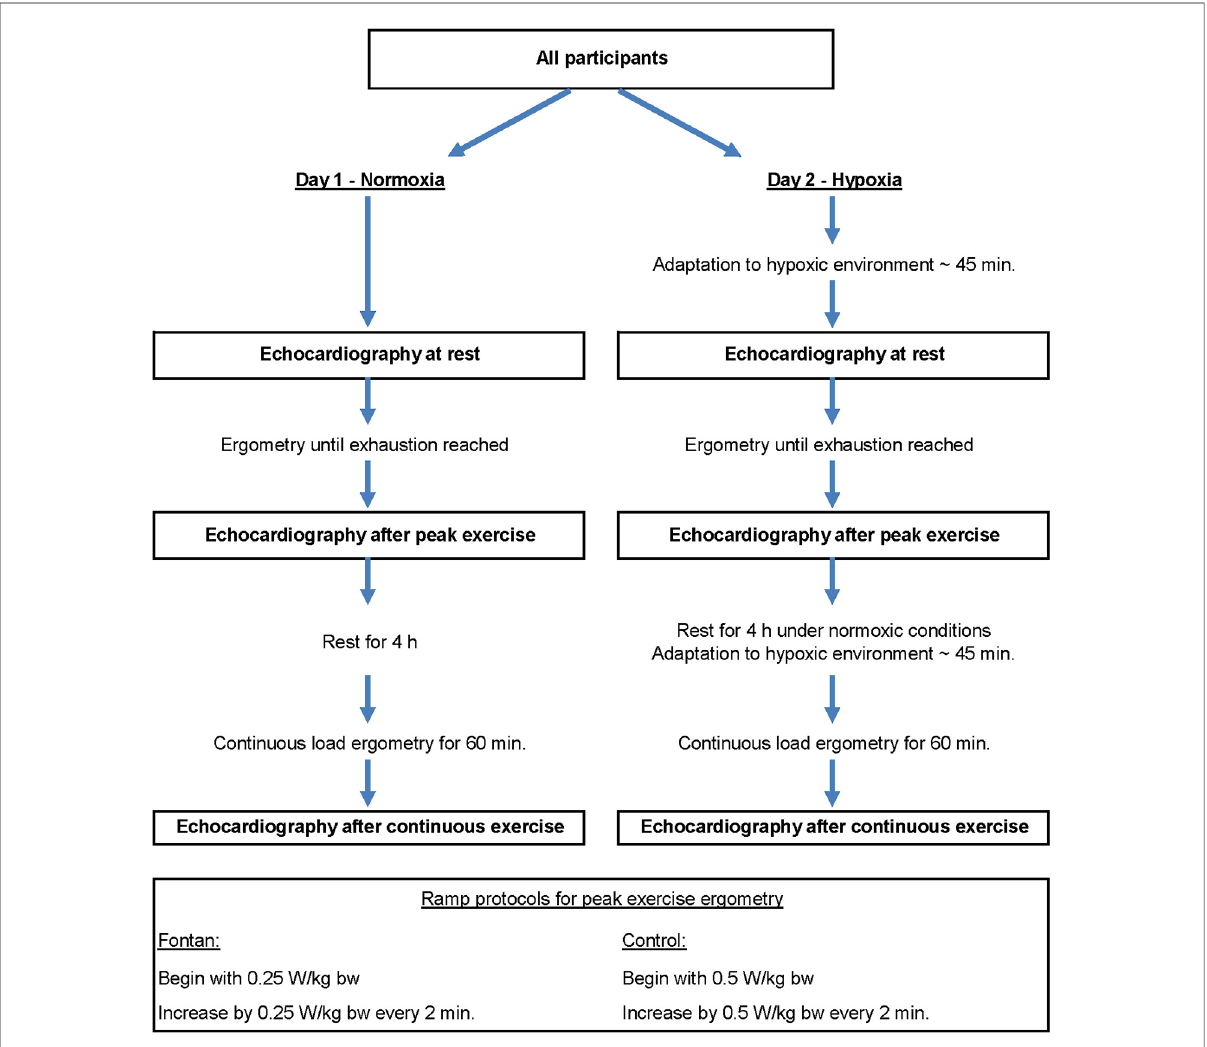
FIGURE 1 Study protocol. W=Watt; kg bw=kilogram body